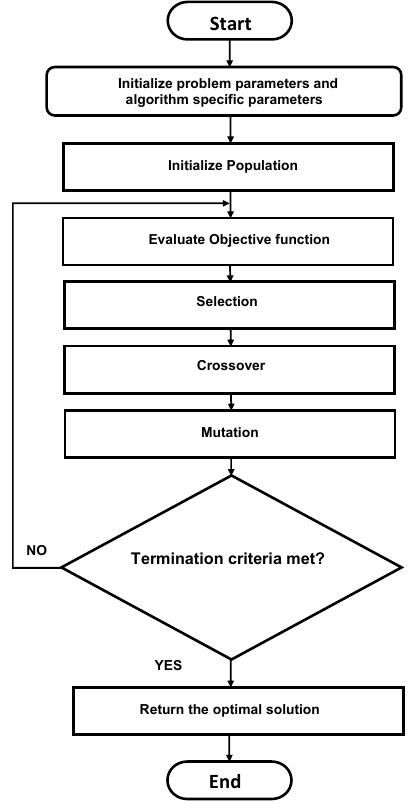
Figure 4. Flow diagram of GA.